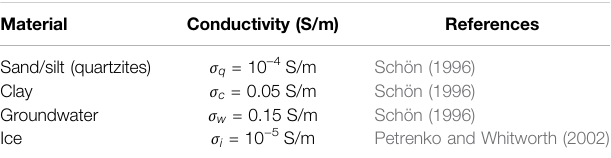
TABLE 2 | Typical material electrical